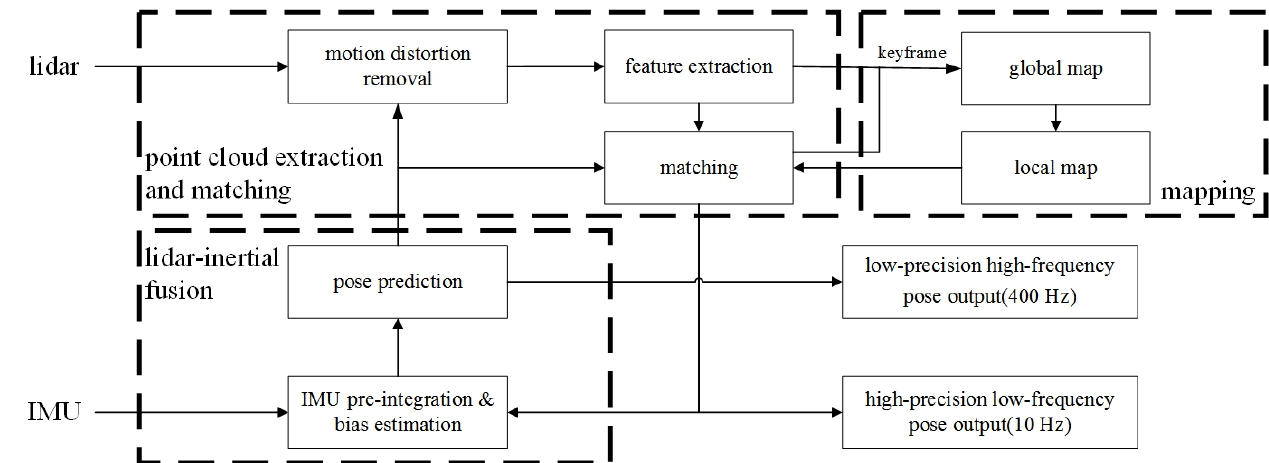
Figure 2. The framework of the proposed navigation